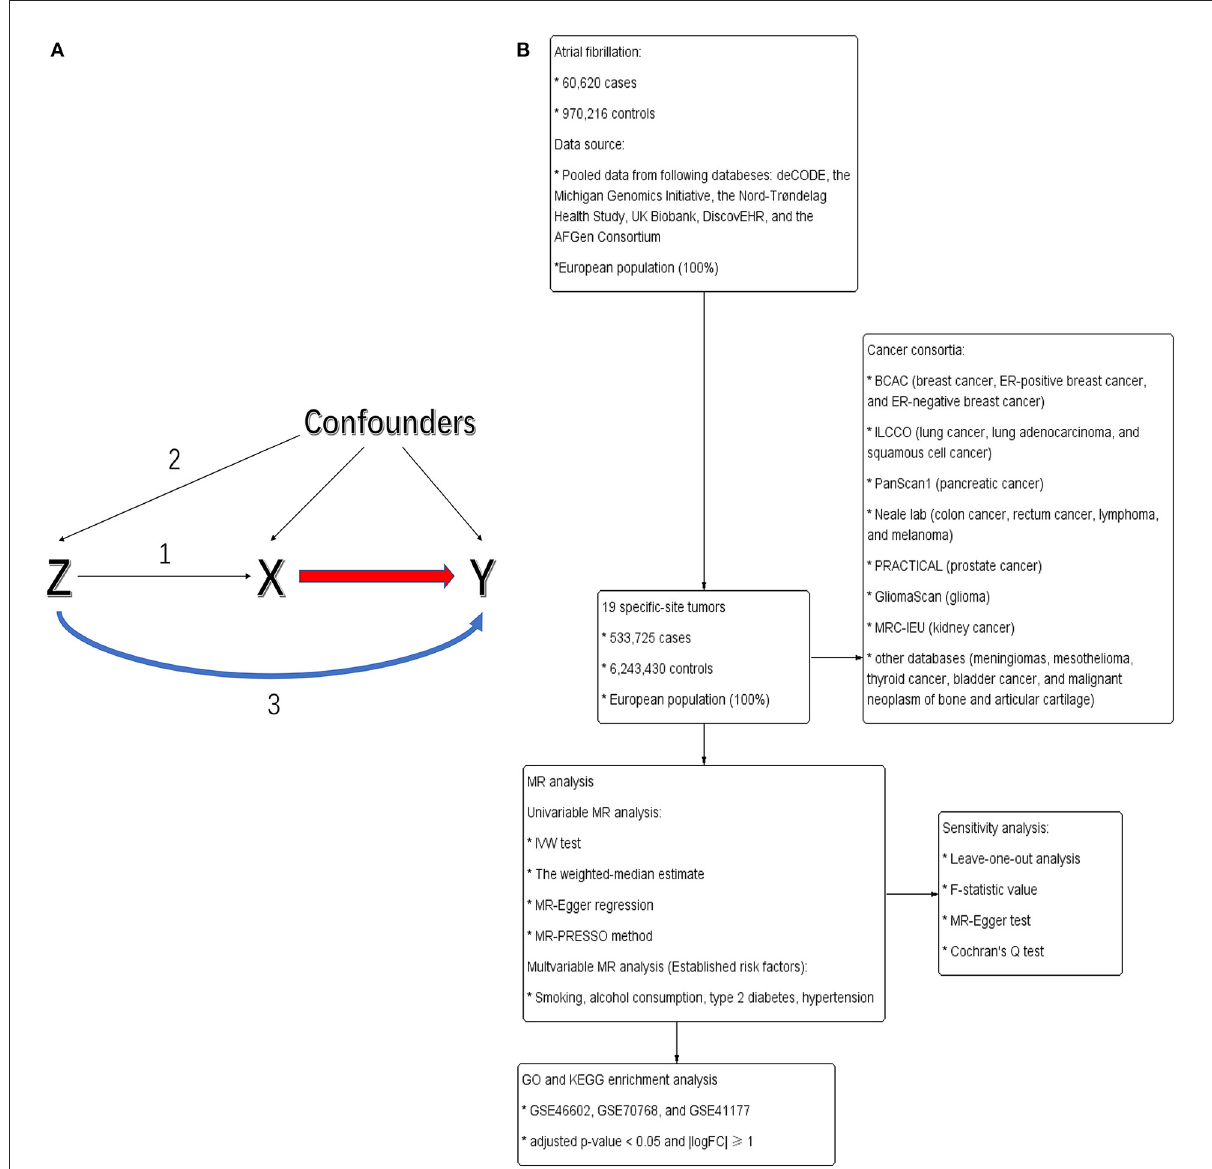
FIGURE1 (A) Directed acyclic graph portraying the design of Mendelian randomization and potential pleiotropy. Genetic variants (Z) served as genetic instruments to evaluate whether exposures (X) were causally related to outcomes (Y). Numbers 1–3 represent assumptions 1–3. (B) The flowchart of this